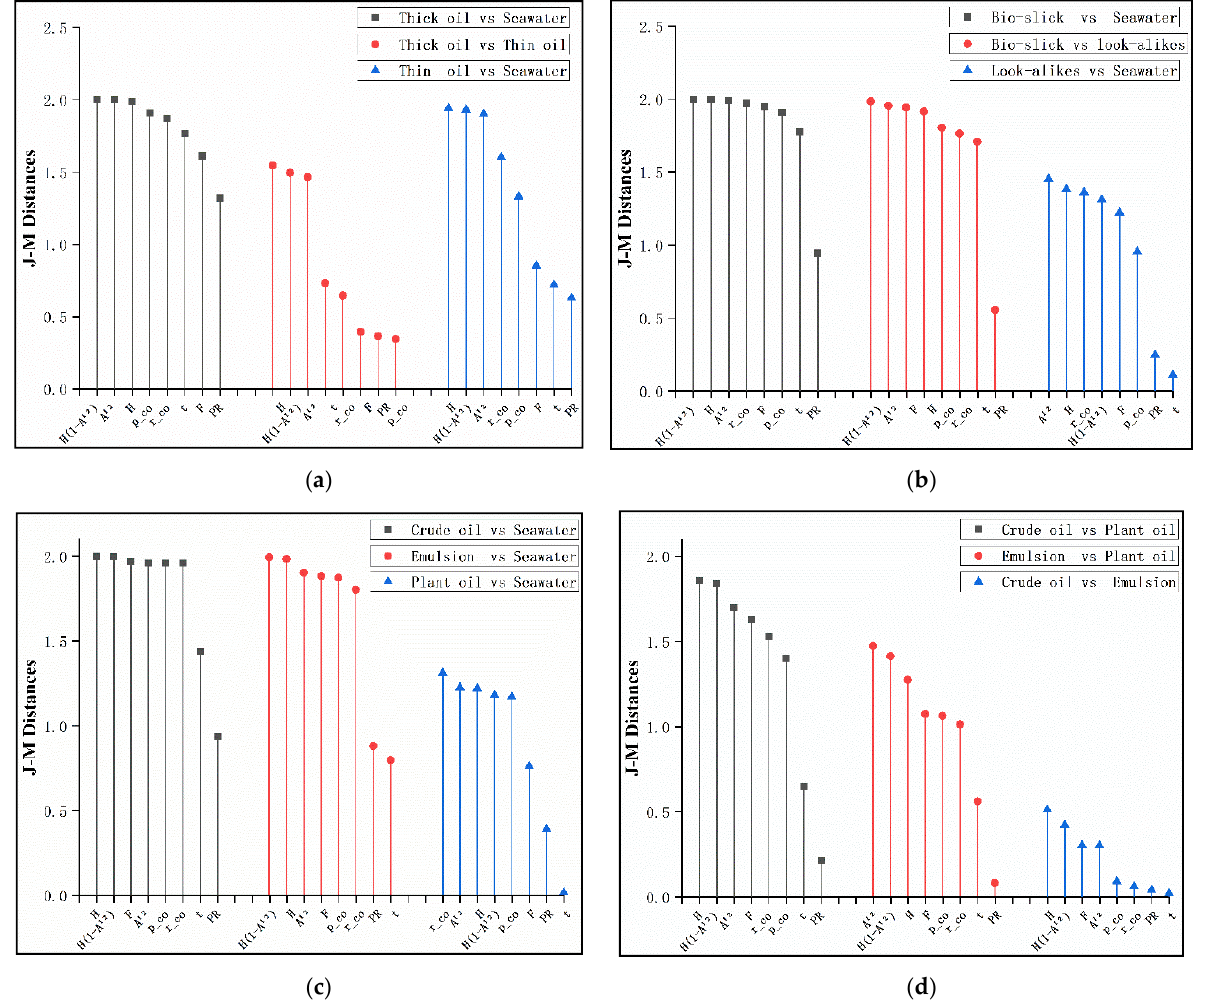
Figure 10. J–Mdistance measurement results for different types of polarimetric feature. ( a ) Relative thickness of oil slick. ( b ) Oil slick vs. look-alikes. ( c ) Different types of oil slick versus seawater. ( d ) Different types of oil slick.